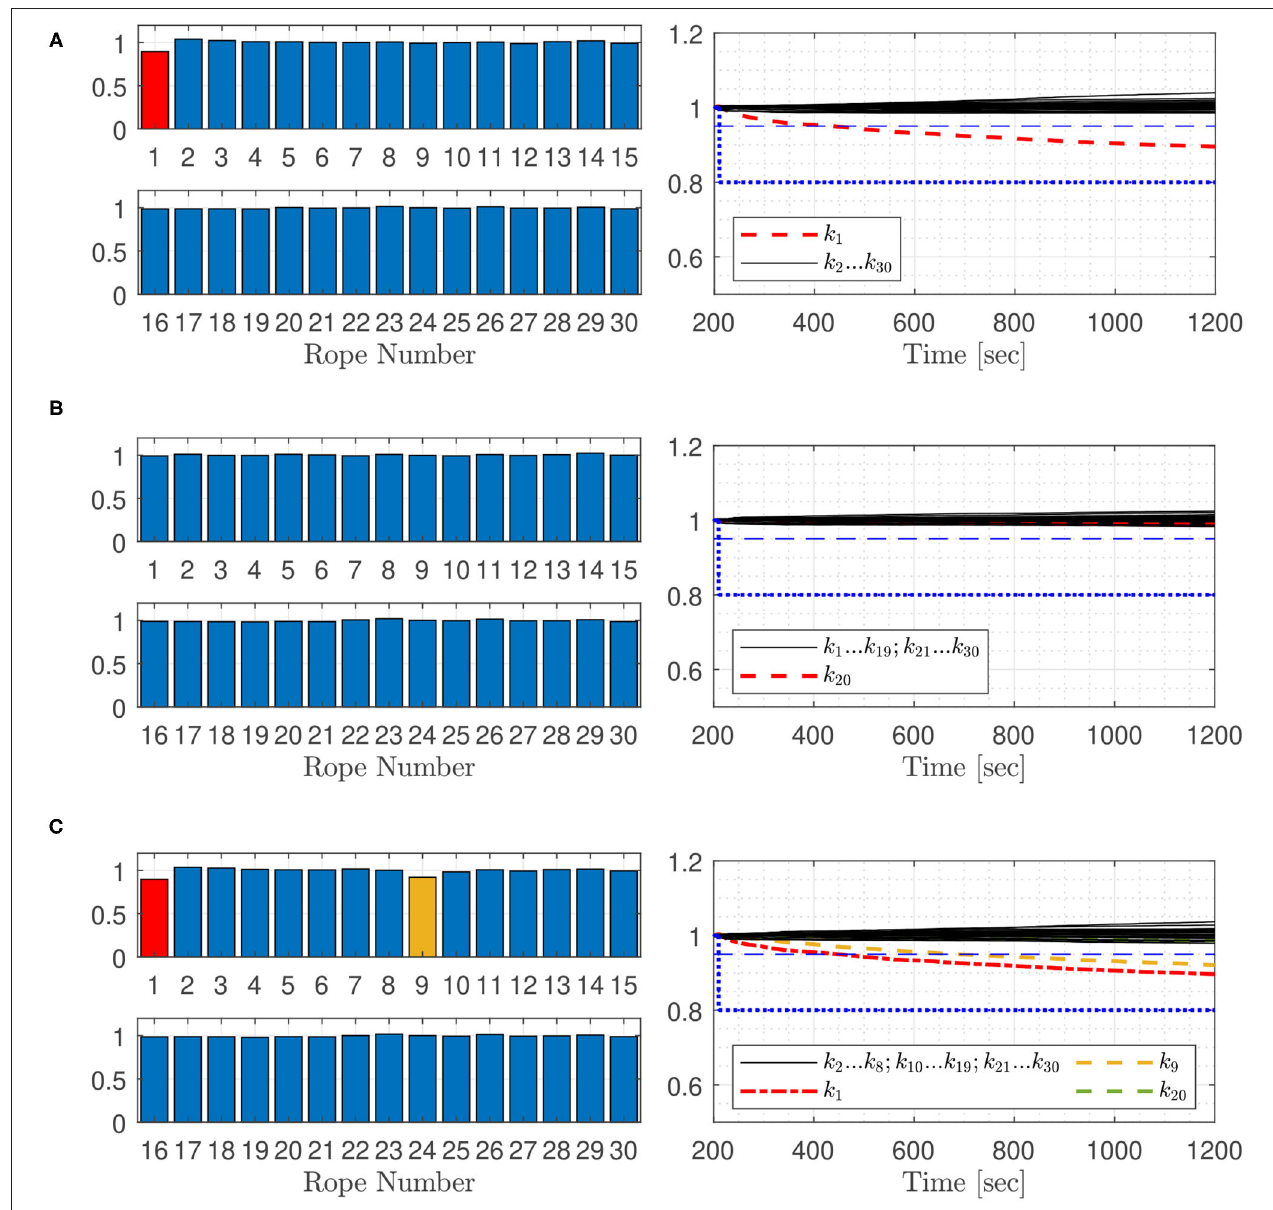
FIGURE 10 | Normalized estimated rope stiffness test cases 4A (A) , 4B (B) , and 4C (C) .